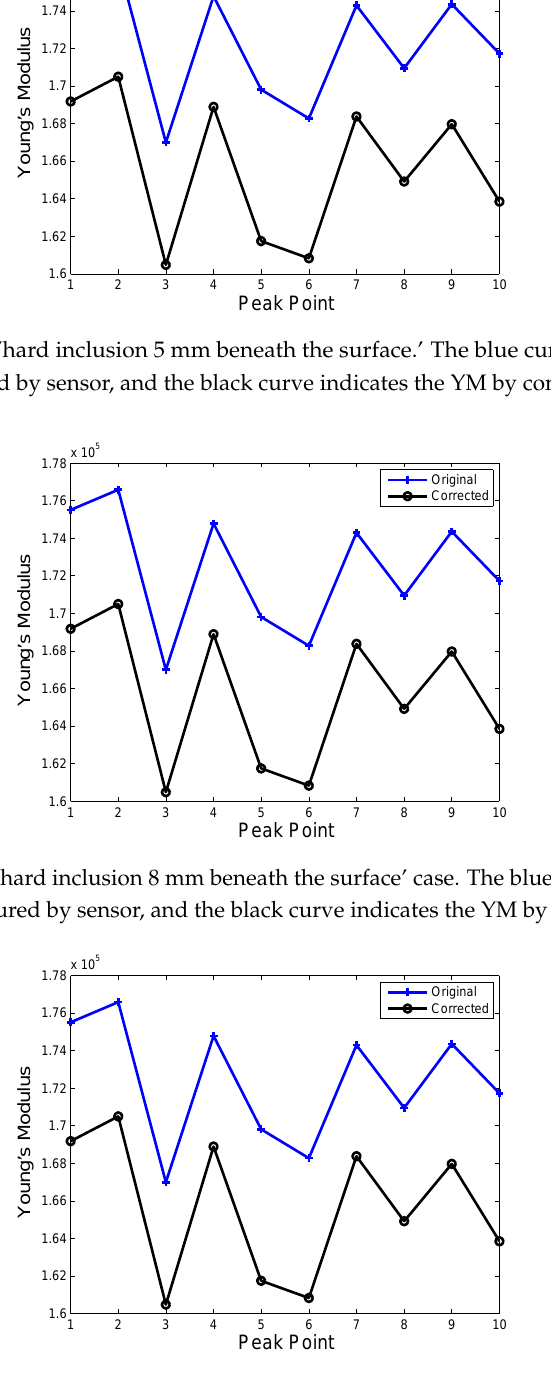
Figure 19. YM for the ’hard inclusion 10 mm beneath the surface’ case. The blue curve denotes the YM by original force measured by sensor, and the black curve indicates the YM by compensated